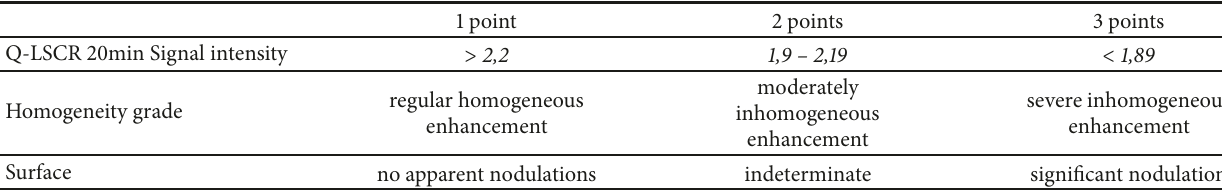
Table 1: Triple test scoring